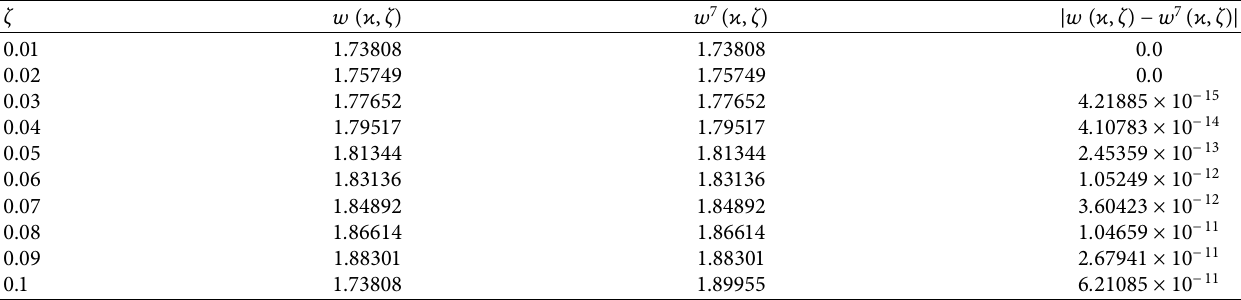
Table 12: | w ( ϰ , ζ ) − w 7 ( ϰ , ζ )| of Problem 3 at ϰ � 1 . 0 and λ � 2 . 0 when ϖ � 1 . 0 determined by LRPSM at plausible locations in the range ζ ∈ [ 0 , 0 . 1 ] .